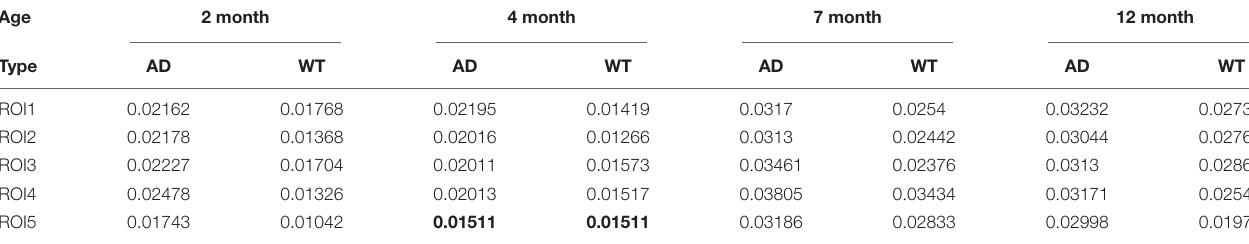
TABLE 2 | The glutamic acid content of each ROI at different months of age.